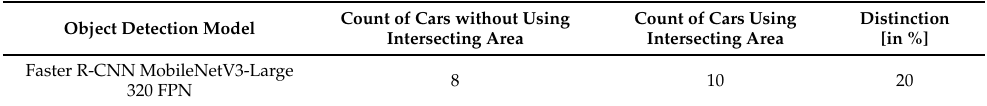
Table 2. Evaluation of the object tracking algorithm.